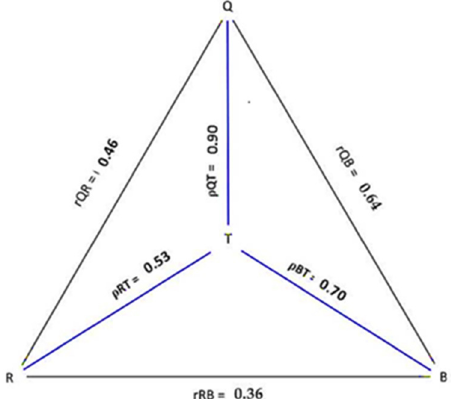
Figure 4. Graphical representation of the method of triads between vitamin D intakes estimated by the VitD-FFQ (Q), seven days Food record = R and Biomarkers = B of vitamin D status (serum con- centration of 25-hydroxyvitamin D(25(OH)D)) for women participant ( n =